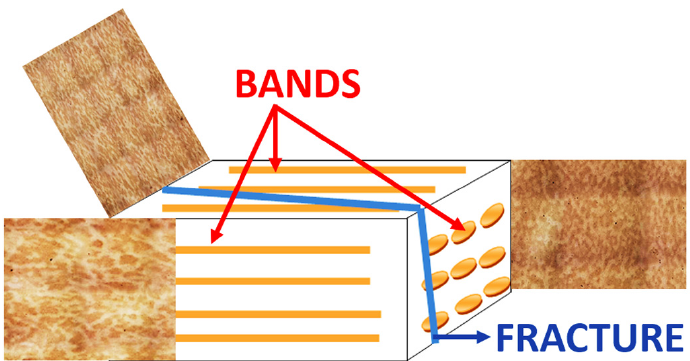
Figure 4. Image of the etched surface of die insert cross-section.